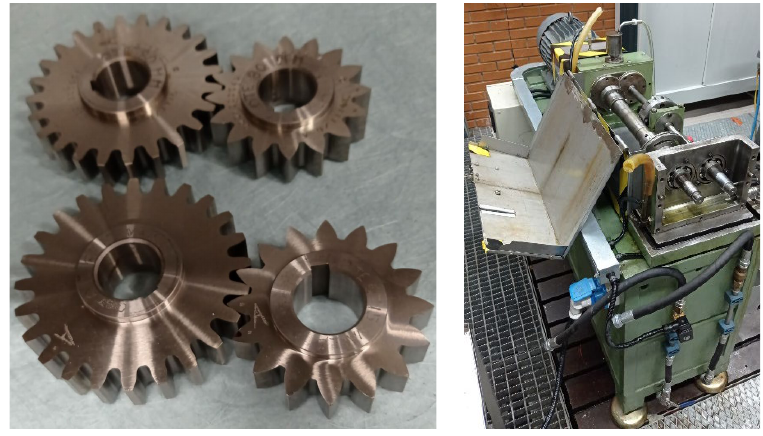
Figure 1. FZG rig test.